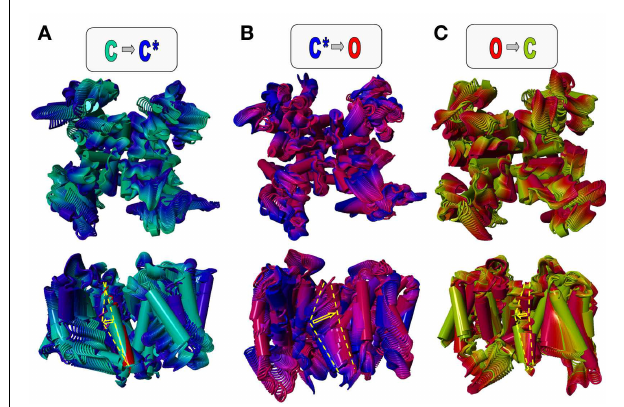
FIGURE 5 | Dynamic model of gating transitions in Kv7.1/KCNE1 channels. The closed (C), pre-open (C*), and open (O) state models described by Smith et al. (2007) and Strutz-Seebohm et al. (2011) were used to generate dynamic models using simple morphing approaches.The gating of Kv7.1/KCNE1 channels can be approximated by a simplified circular gating model. Major gating steps are C ⇒ C* (A) , C* ⇒ O (B) , and O ⇒ C (C) (colors as indicated in the letters above the models). For clarity the central axes of the KCNE1 start and end models are marked by the yellow dashed lines, and the direction and extent of the proposed motion is indicated by the yellow arrow. In (A) the KCNE1 start model is shown in red and the end model in magenta.The morphs indicate larger motions of KCNE1 during channel gating in the gating cleft of Kv7.1 channels. A particularly large gating motion aroundThr58 is seen from C* ⇒ O (B) , suggesting a major energetic barrier.This may be the molecular basis of the dramatically slowed activation of Kv7.1 by association with KCNE1. However, calculation of energies on the models is highly speculative because specific interactions with surrounding membrane molecules [e.g., PI(4,5)P 2 ] would be highly influential, and the current knowledge on lipid-channel interactions is not sufficient to allow for precise